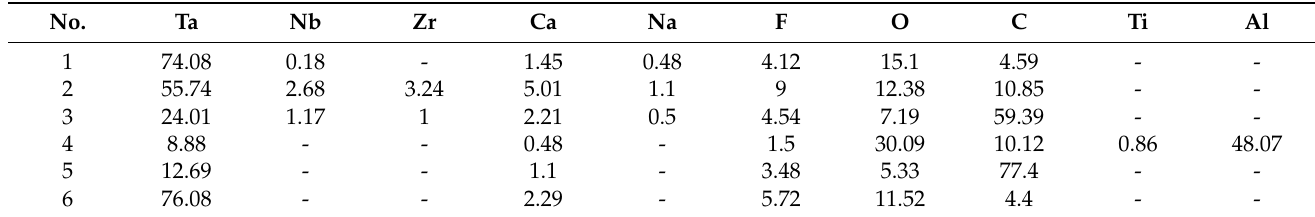
Table 2. EDX results of decomposed slag under different oxygen partial